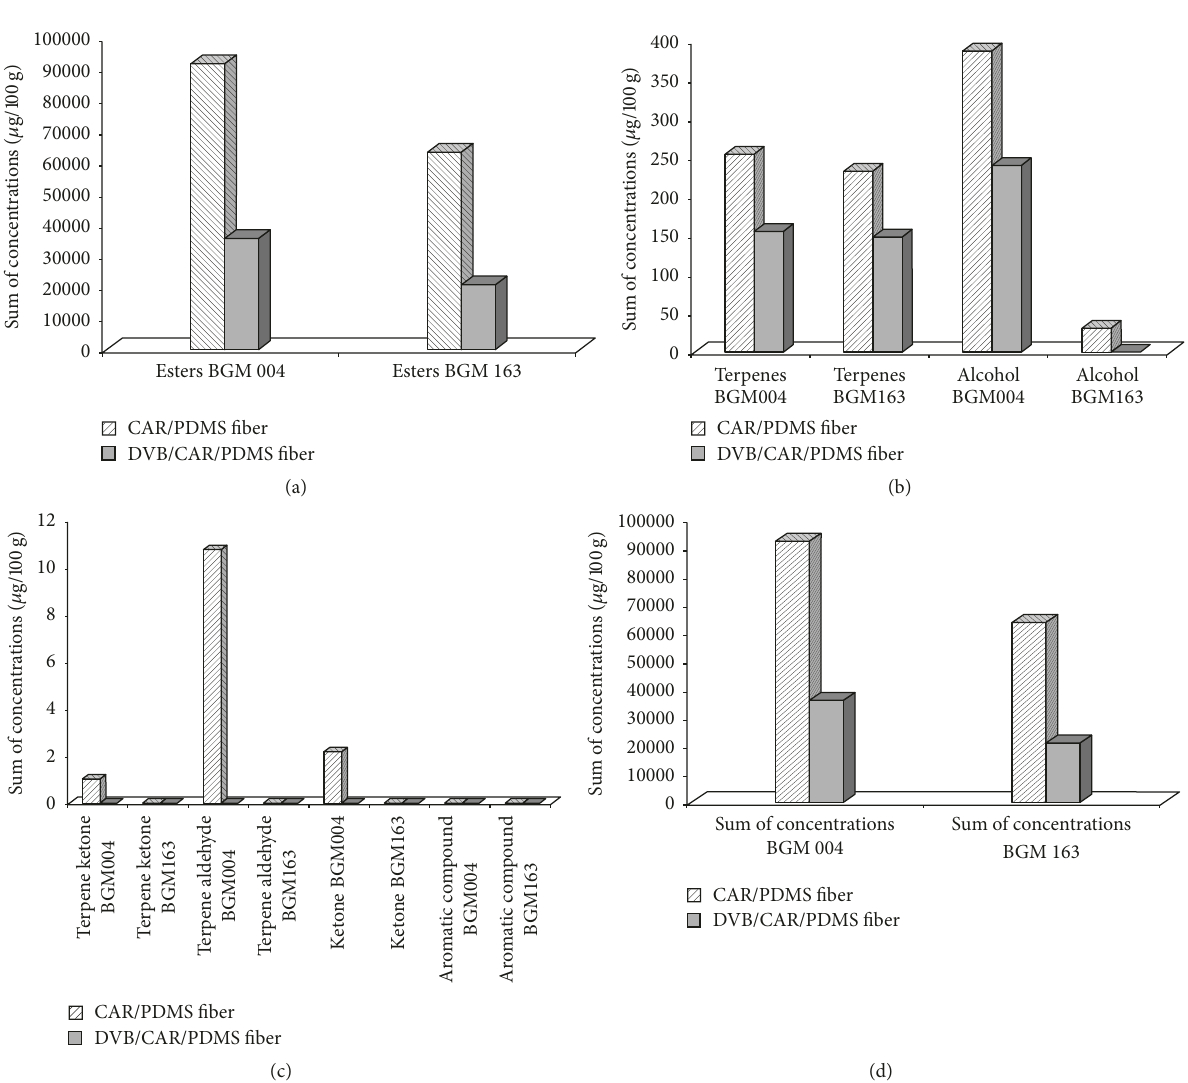
Figure 2: Total concentration ( 𝜇 g/100g) of esters, terpenes and derivatives, alcohols, ketones, and aromatic compounds semiquantified in passion fruit